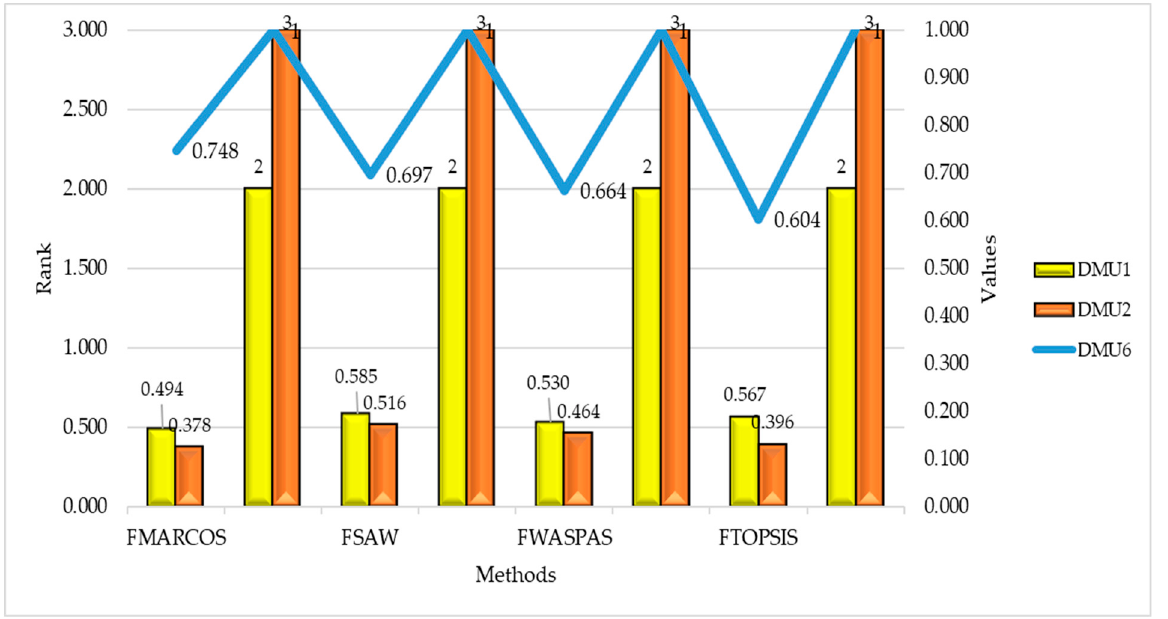
Figure 6. Values and ranks of DMUs using the fuzzy SAW, fuzzy WASPAS, and fuzzy TOPSIS methods.